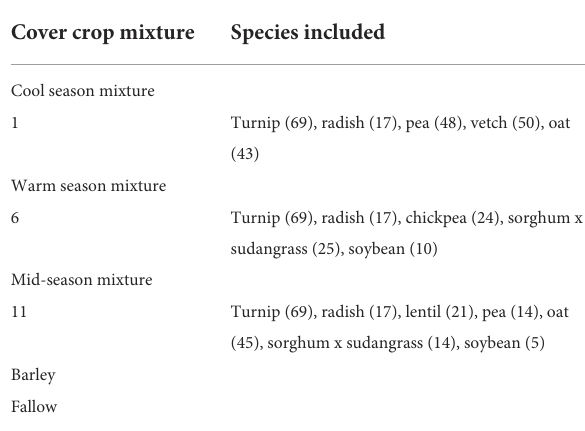
TABLE 1 List of species in each of treatments evaluated in the cover crop trial. Seeding rates (seeds m − 2 ) are shown in parentheses behind each